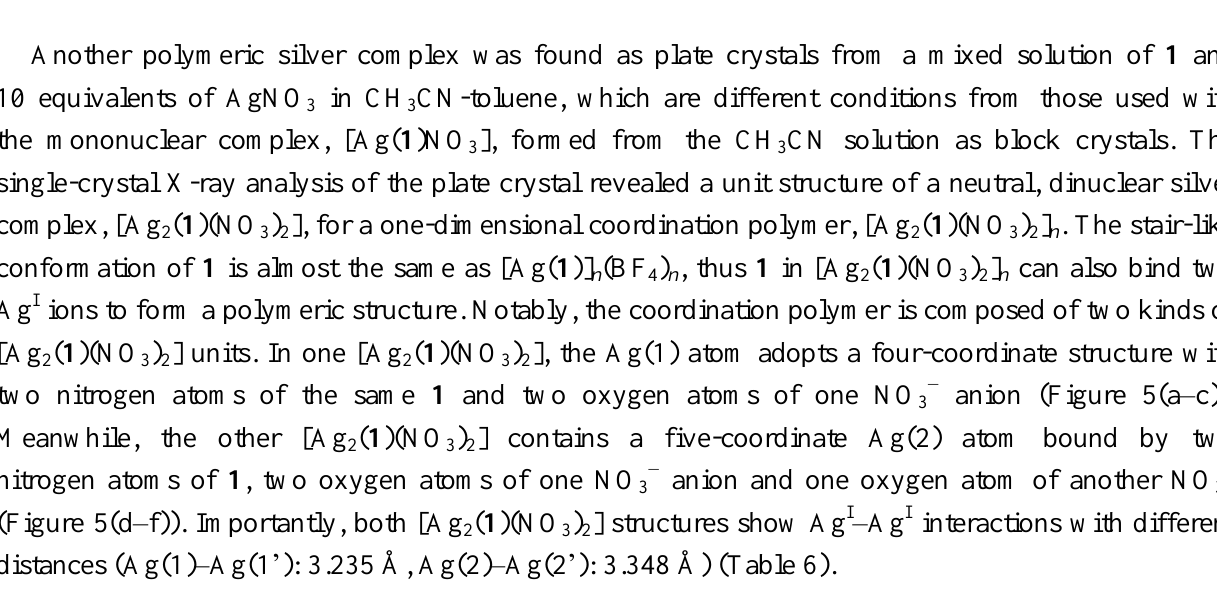
Table 5. Selected bond lengths (Å) and angles (deg) for [Ag( 1 )]